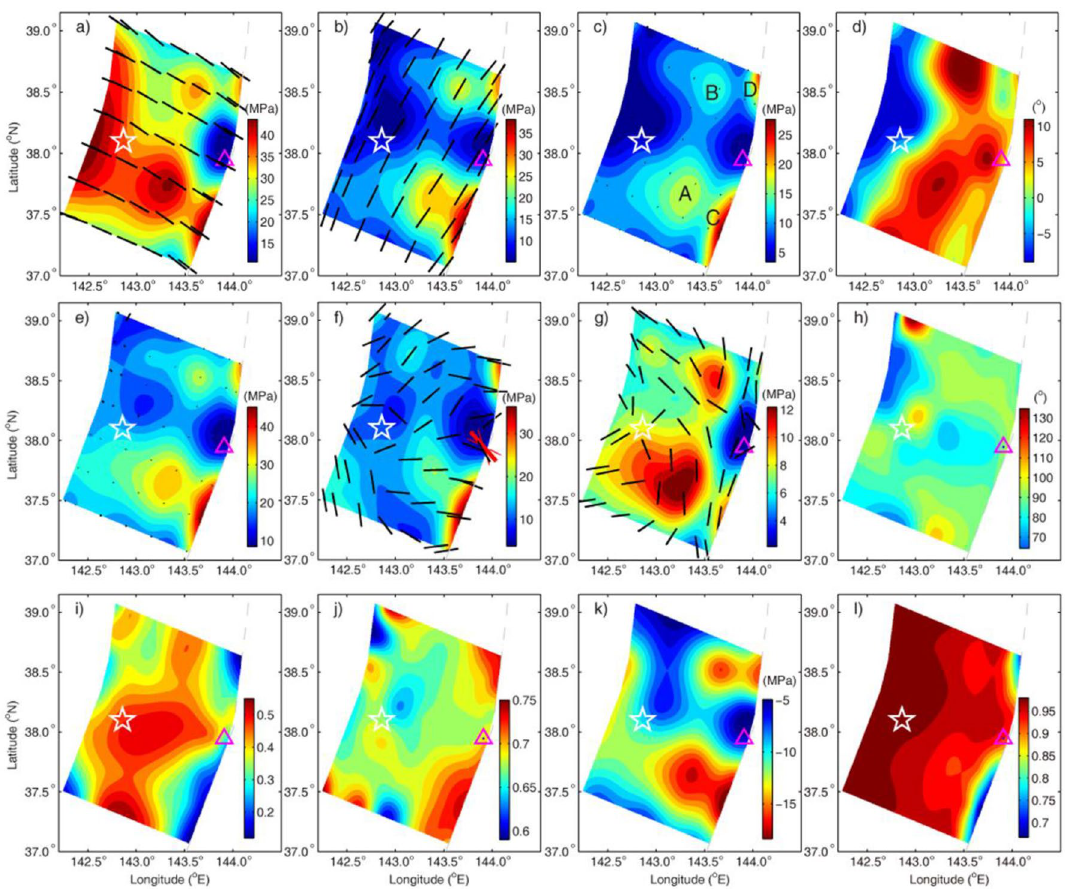
Figure 2. Recovered ME in the fault rupture zone of the Tohoku-Oki earthquake. ( a – d ) Maximum ( S 1 ), intermediate( S 2 ), minimum( S 3 ) principal effective stresses and the dip angle of S 1 before the mainshock, respectively. ( e – h ) S 1 , S 2 , S 3 , and the dip angle of S 1 after the mainshock, respectively. ( i ) Friction coefficient. ( j ) Skempton coefficient, a parameter to reflect a capacity of pore-fluid pressure change under one unit change of mean total compressive stress. ( k ) Pore-fluid pressure change. ( l ), Pore-fluid pressure ratio of the pre-fault rupture. Star denotes the hypocenter of the mainshock. Black bars, normalized principal stresses viewed from above, full length indicates horizontal, and length decreases with increasing the dip angle. A thick and two thin red bars in ( f ) represent the predicted maximum horizontal stress direction range from the borehole breakout and error angles. Triangle denotes the location of IODP JFAST